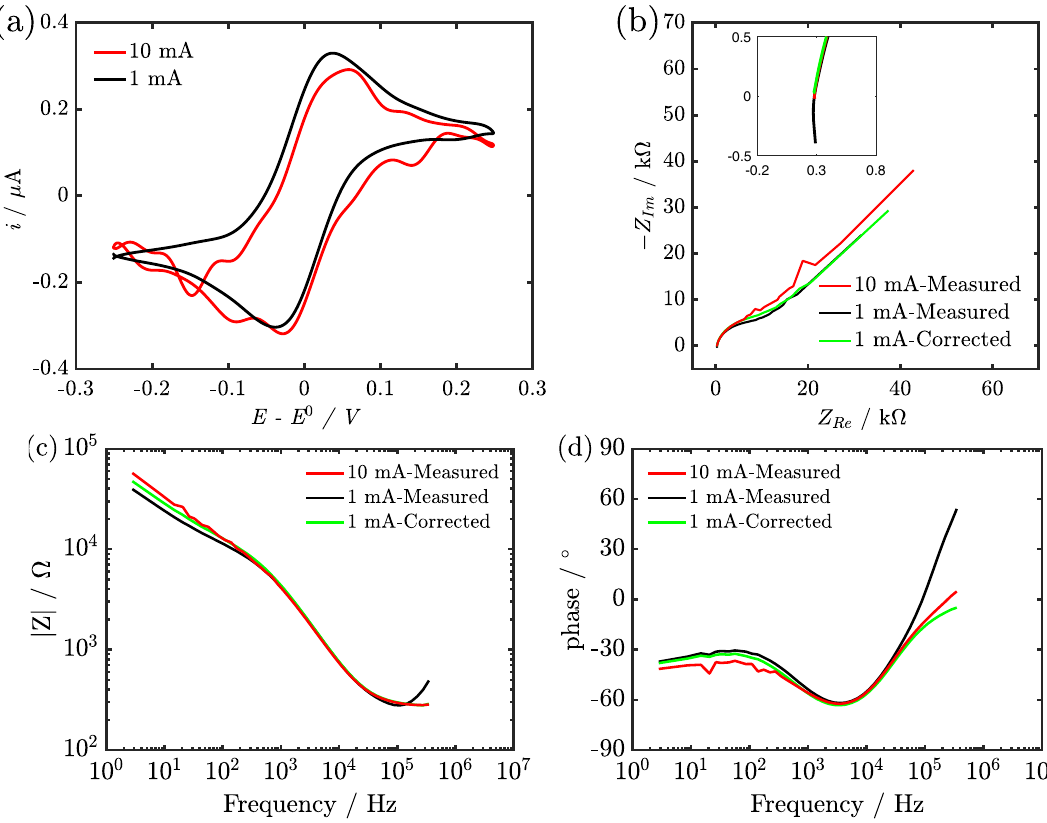
Figure 4. ( a ) Quasi Voltammogram obtained at the different current range for 250 µ m Pt electrode in 5 mM K 3 [ Fe(CN) 6 ] solution with 1 M KCl as supporting electrolyte. ( b ) Nyquist plot of impedance spectra obtained for 250 µ m Pt electrode in 5 mM K 3 [ Fe(CN) 6 ] solution with 1 M KCl as supporting electrolyte using 1 mA and 10 mA current range with an insert showing the high-frequency region. ( c ) and ( d ) Magnitude ( | Z | ) and Phase of impedance spectra obtained for 250 µ m Pt electrode in 5 mM K 3 [ Fe(CN) 6 ] solution with 1 M KCl as supporting electrolyte using 1 mA and 10 mA current